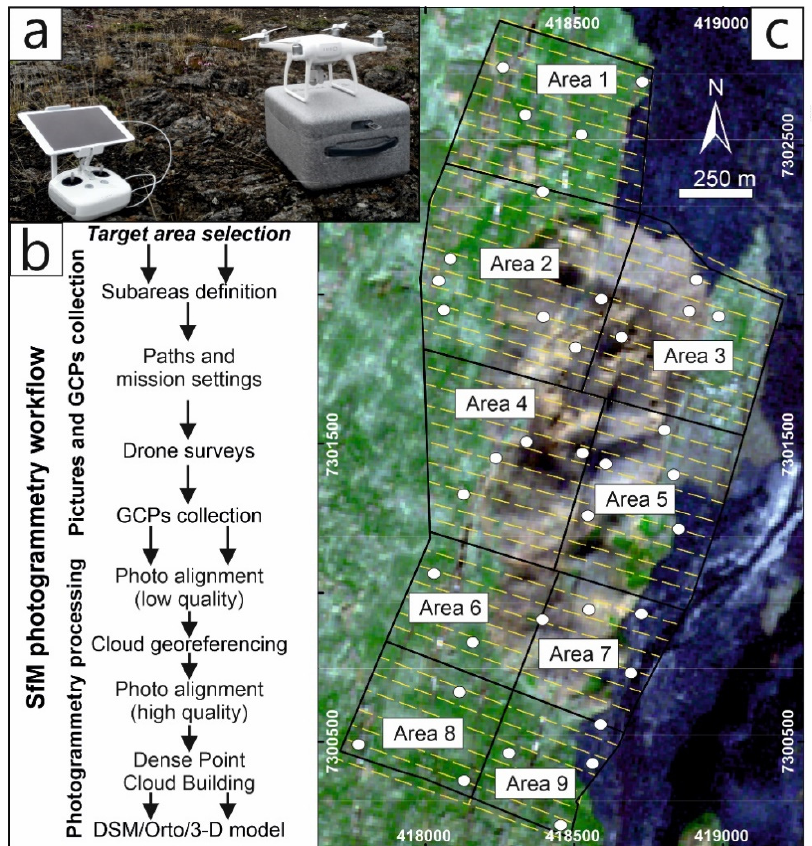
Figure 2. ( a ) The quadcopter used in the present work. ( b ) Overall workflow used in the present research to generate the 3-D model, the DSM and the orthomosaic using SfM photogrammetry approach. ( c ) Unmanned aerial vehicle (UAV) flight paths (yellow line) above the nine subareas surveyed between 80 and 95 m height. White dots indicate the 37 GCPs collected to georeference the model. Satellite image is from Sentinel 2 (European Space Agency—ESA, https: // sentinel.esa.int / web / sentinel / missions / sentinel-2), reference system: